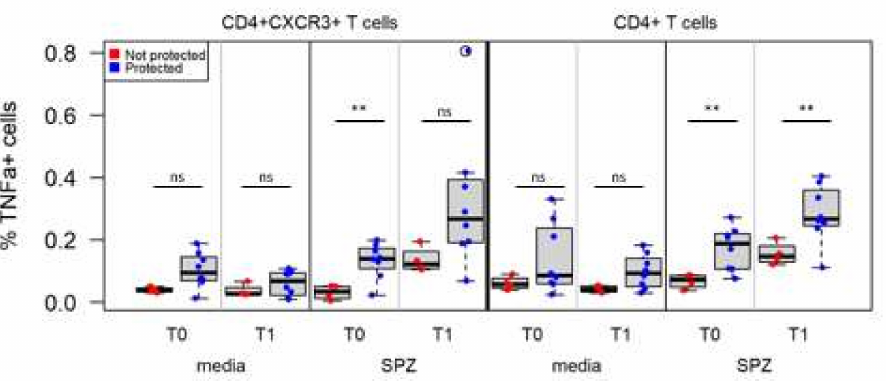
Figure 6. Frequencies of SPZ-specific CD4 + and CD4 + CXCR3 + T cells are significantly higher in pro- tected individuals. Changes in the frequency of CD69 + CD4 + CXCR3 + (Panel A) and bulk CD69 + CD4 + in protected (blue) and non-protected (red) individuals at pre-immune (T0) vs. pre-CHMI (T1) time points. ns = not significant, ** p <